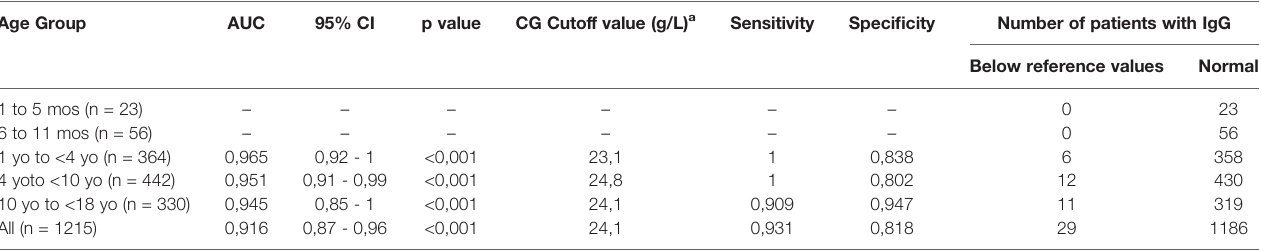
TABLE 2 | CG values as a function of IgG levels.